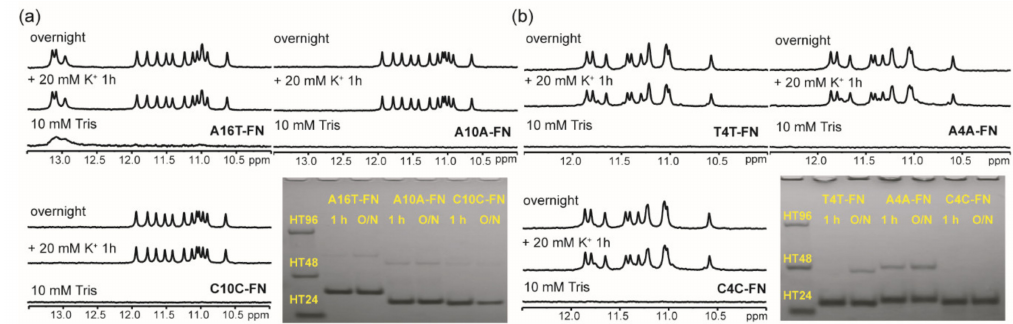
Figure 5. The e ff ect of a single base change in loop 1 and 3 on G4 formation of (G 3 HG 3 N m G 3 HG 3